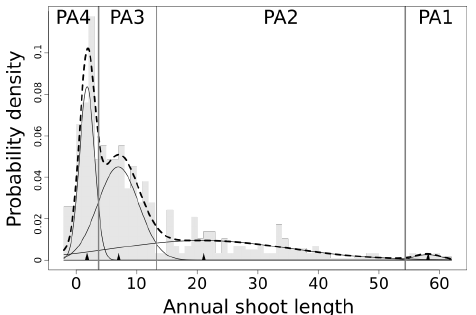
Figure 9. Distribution mixture of annual length to retrieve annual shoot physiological ages (PA). Four normal distributions (continuous curve) are fitted to the frequency distribution of annual shoot length (grey histograms) to build the distribution mixture model (dotted curve). The black triangles show the average value of each distribution, and the vertical lines show the position of intersections between two distributions used to retrieve PAs.